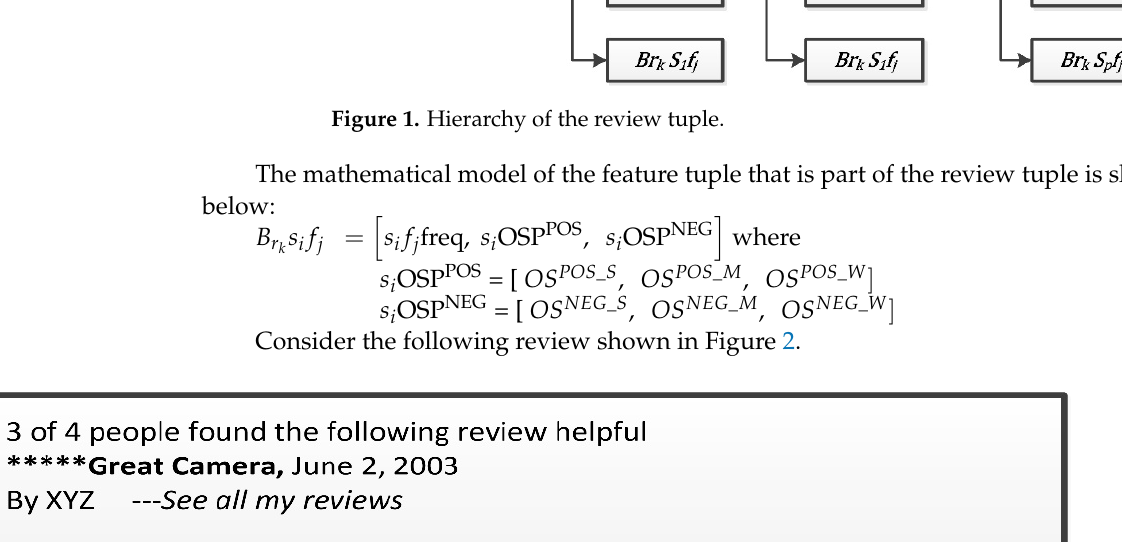
Figure 2. Example